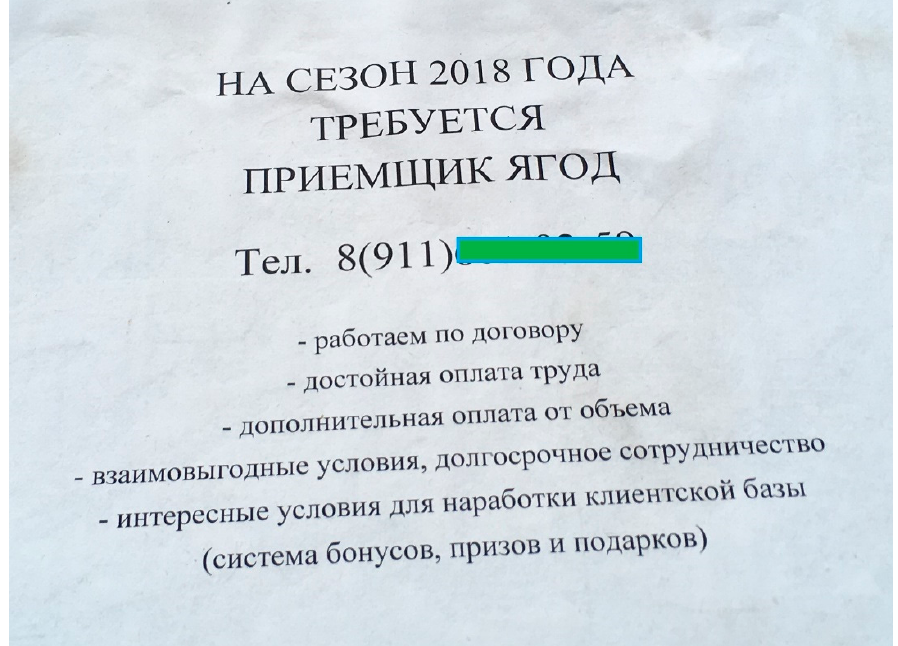
Figure 9. An advertisement about a berry receiving inspector job vacancy for 2018 season, Kalevala.